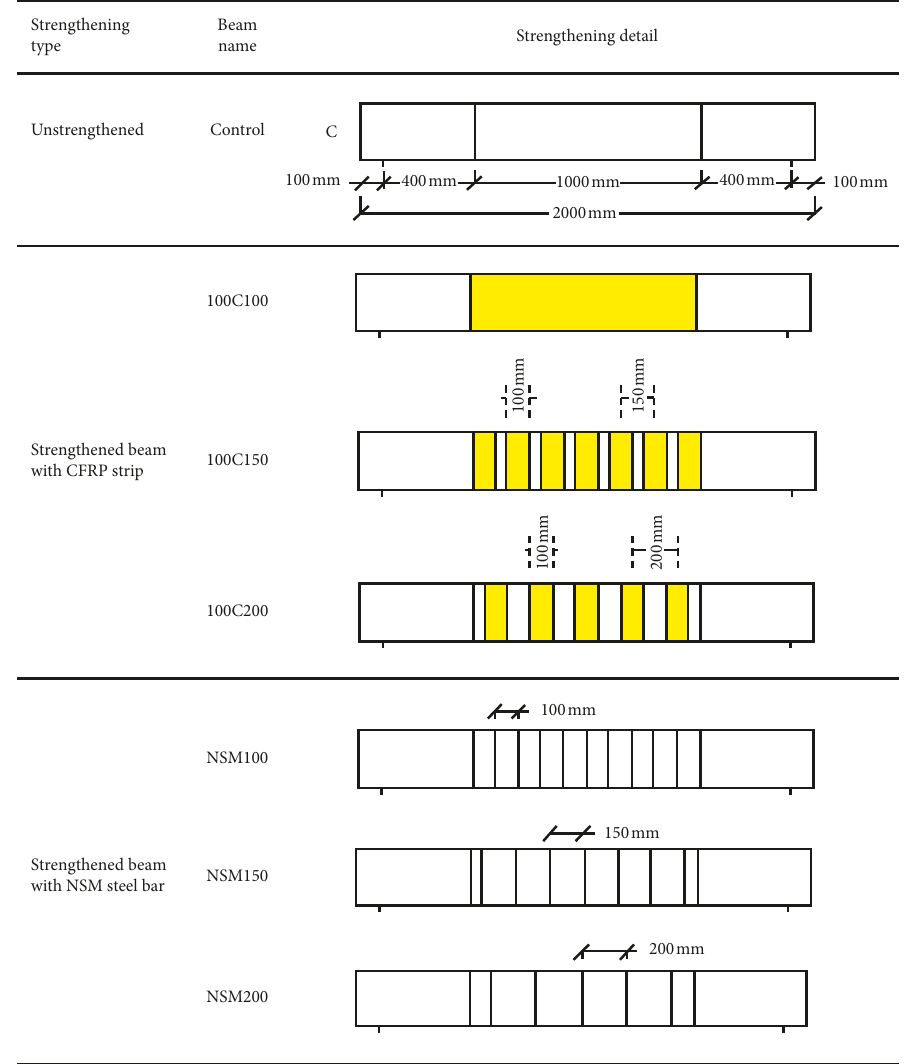
Figure 2: Strengthening of the test